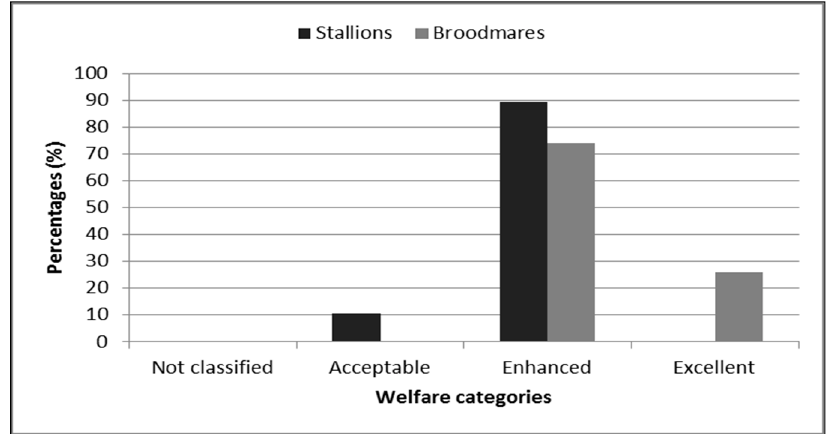
Figure 1. Classification of the stallions and broodmares in different welfare categories, based on the final score.